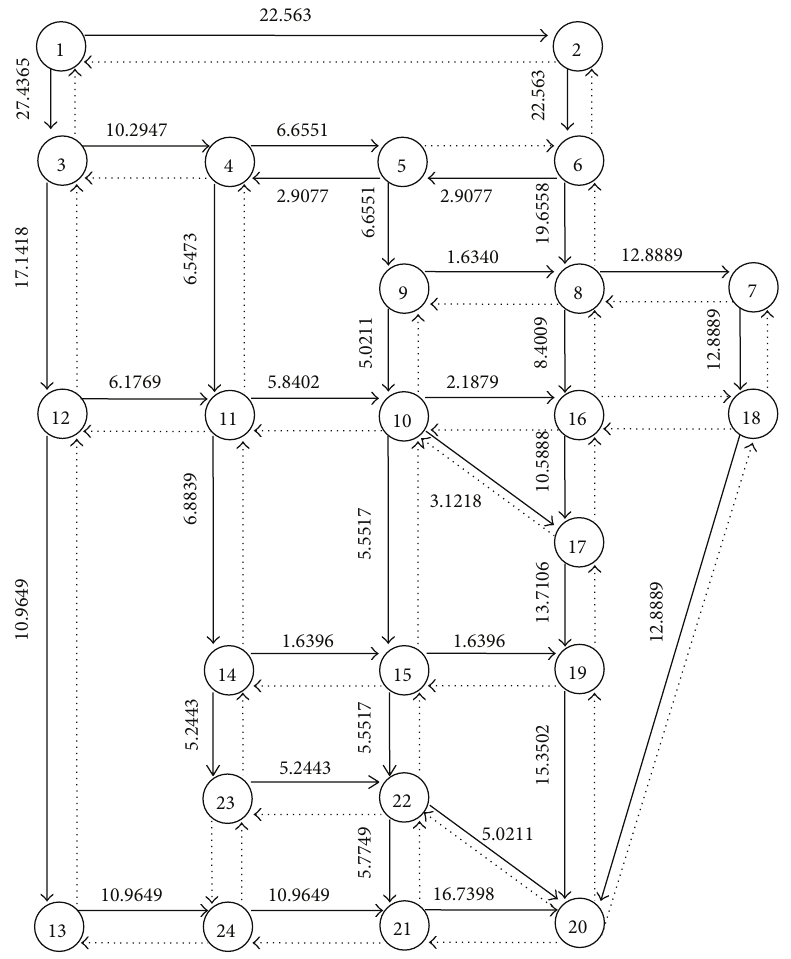
Figure 3: The Sioux Falls test